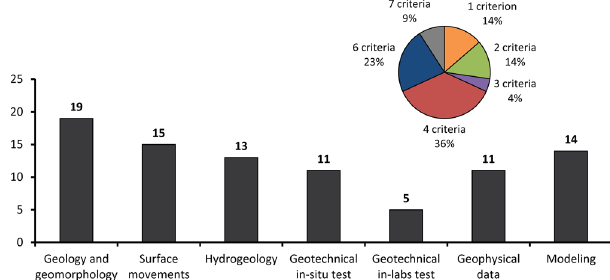
Fig. 4. Inventory of investigations performed before designing the 23 reported EWSs performed and percentage of total number of criteria investigated per site. The total number of investigations is over 23, because 86% of the landslides required more than one type of